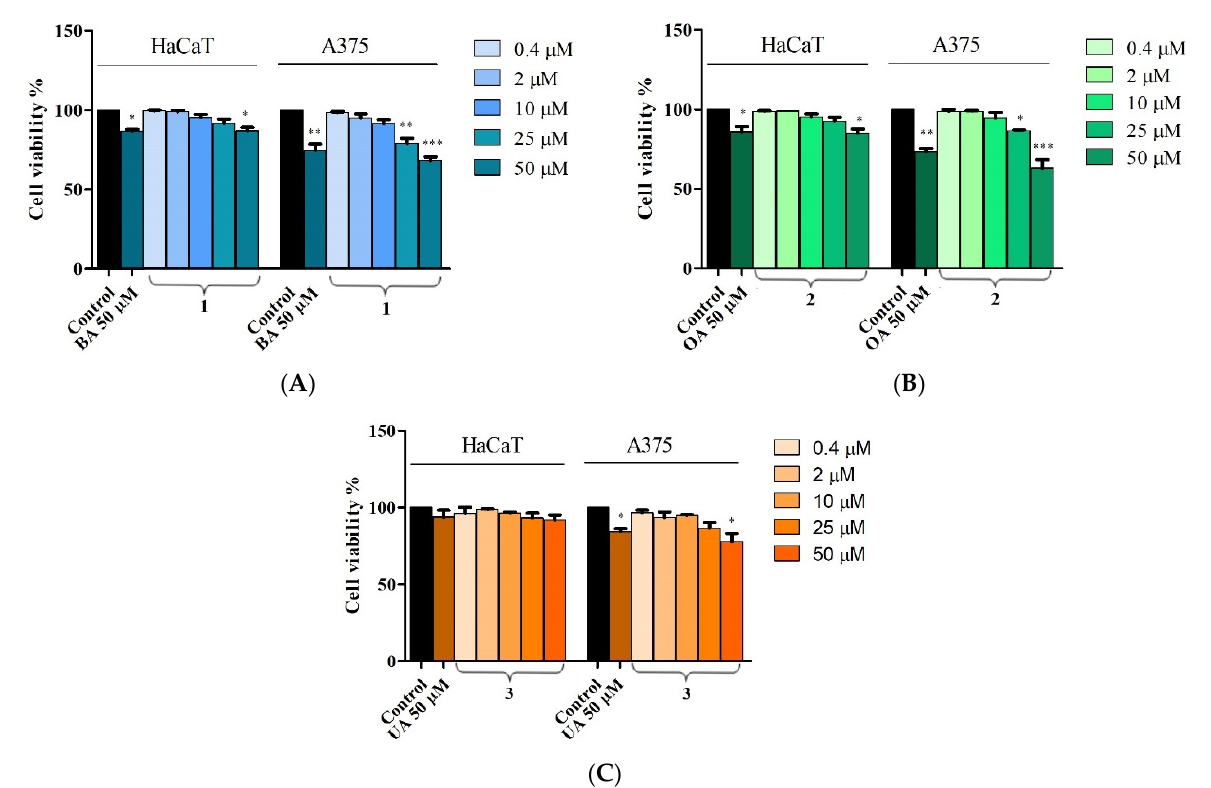
Figure 2. Cell viability of HaCaT and A375 cells after 24 h of treatment with 0.4, 2, 10, 25, and 50 μ M of compounds 1 ( A ), 2 ( B ), and 3 ( C ), determined using the Alamar Blue assay. The results are expressed as cell viability percentage (%) normalized to control (100%). The data represent the mean values ± SD of three independent experiments performed in triplicate. The statistical differences vs. the control was determined using one-way ANOVA analysis followed by Tukey’s multiple comparisons post-test (* p < 0.05, ** p < 0.005 and *** p < 0.0001).